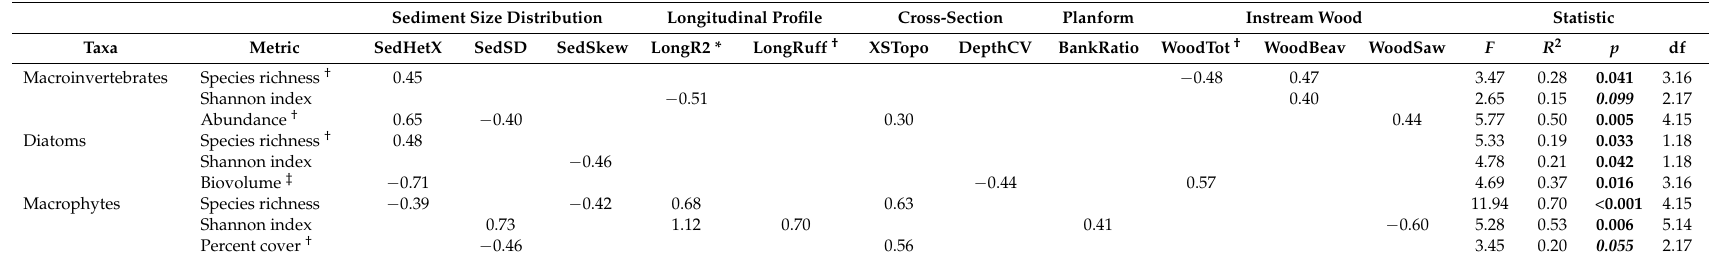
Table 3. Summary of the multiple linear regression analyses used to explain patterns of species richness, Shannon diversity index, and abundance of macroinvertebrates, diatoms, and macrophytes along 20 stream reaches with varying geomorphic complexity. We report standard partial regression coefficients for each explanatory variable with the F -value, p -value, and adjusted R 2 for the full model. Significant p -values are in bold ( α = 0.05) or in bold italics ( α = 0.10). We show only significant contributors to the models. We explain abbreviations for the geomorphic complexity metrics in Table 1. Please note that we have inverted the signs of the relationships with Het2 and LP_R2 here to make interpretation easier, because these metrics become more negative with increased